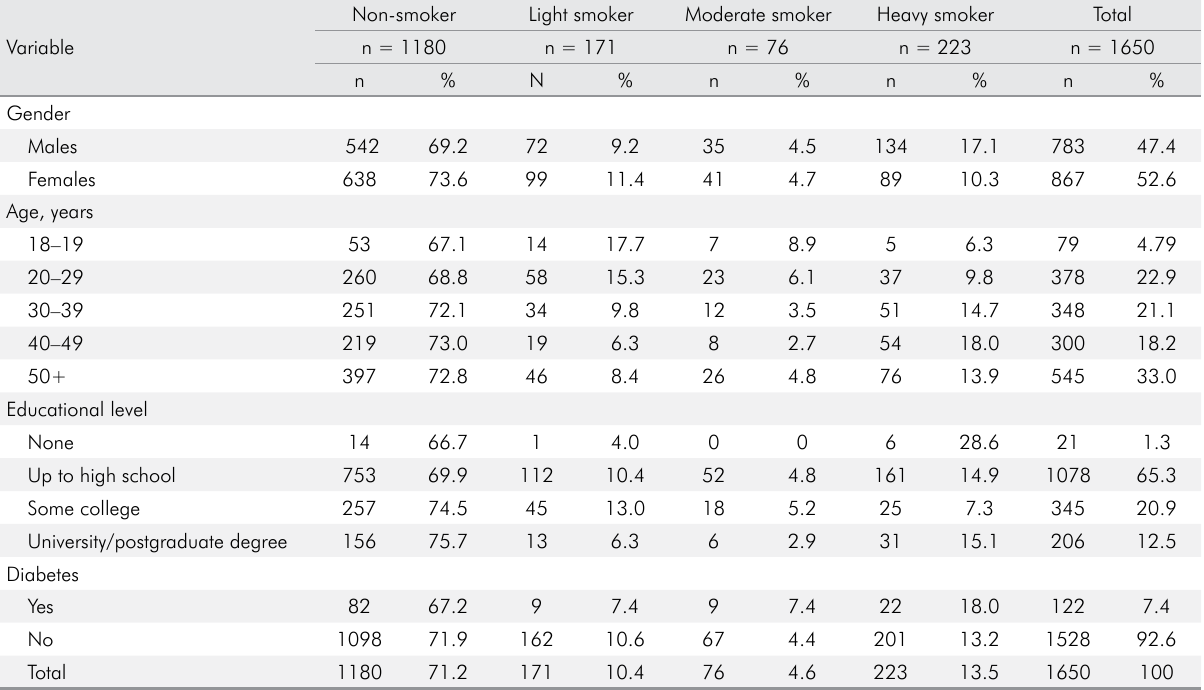
Table 1. Sociodemographic and clinical characteristics of the study sample.